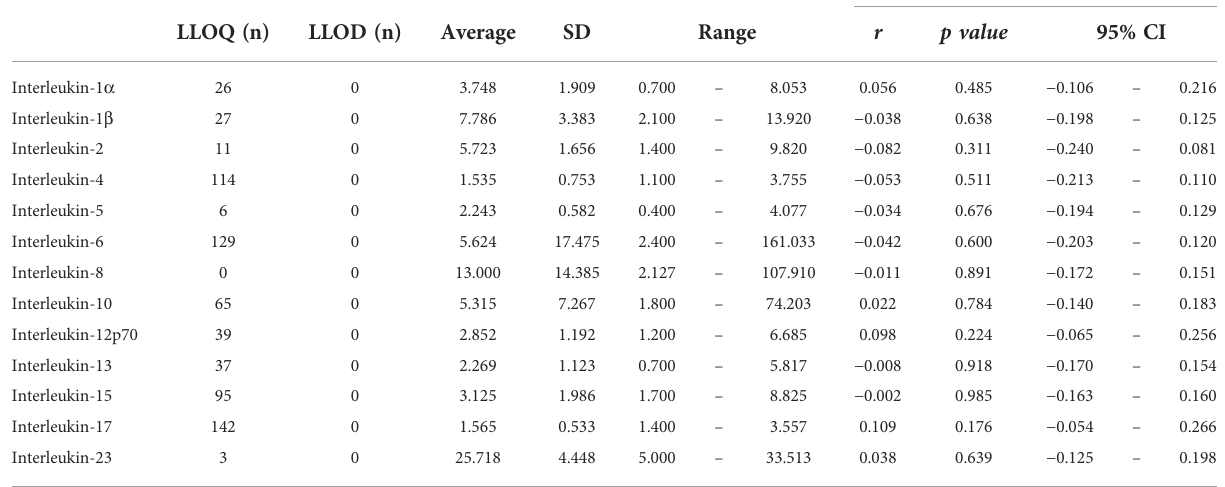
TABLE 4 Interleukin concentration (pg/ml) in cord blood and its correlation with birth